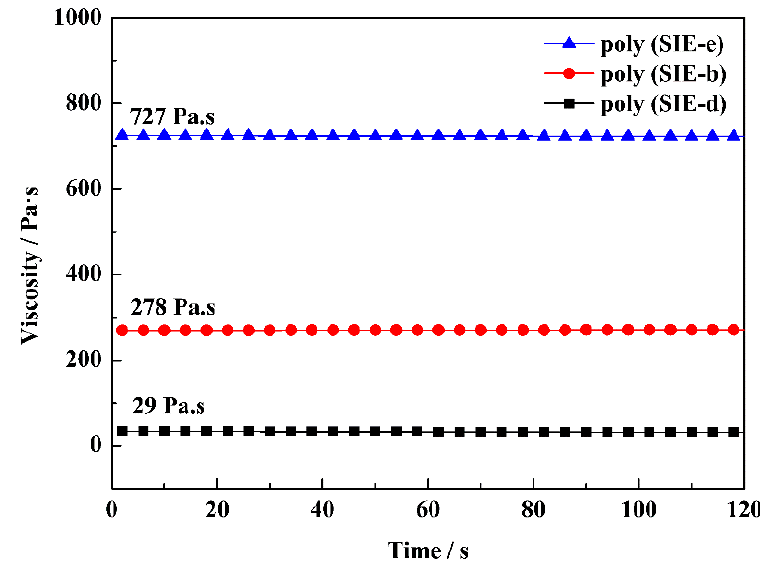
Figure 5. The viscosity of different benzoxazine oligomers at 30 °C.